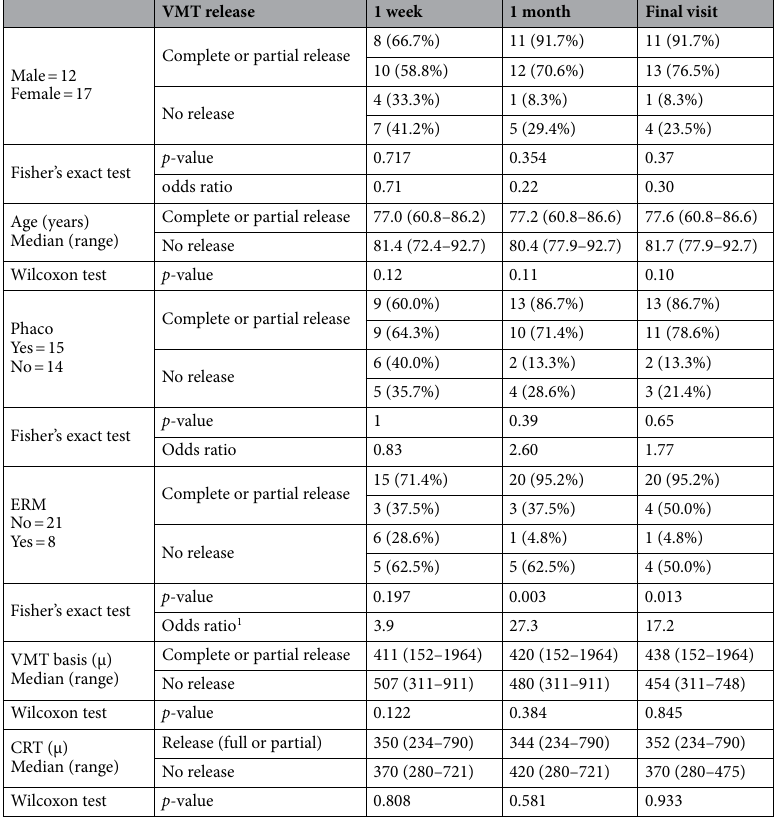
Table 3. VMT release in relation to patients’ characteristics, secondary diagnosis and OCT findings at each time point. ERM epiretinal membrane, CRT central retinal thickness, VMT basis vitreomacular traction adhesion